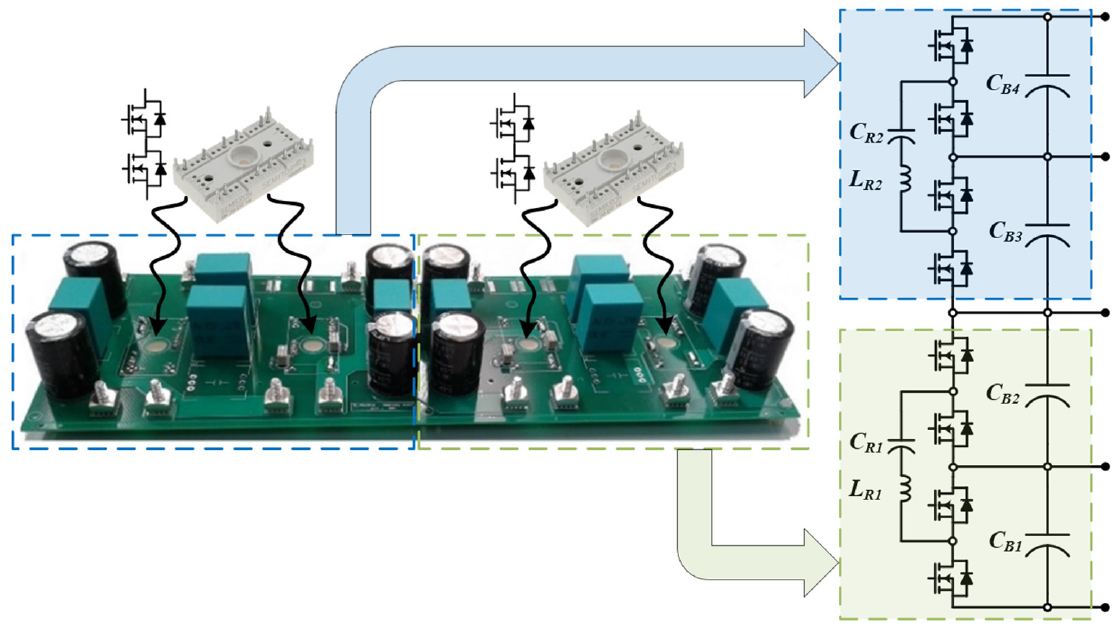
Figure 7. Series resonant balancing circuit prototype.